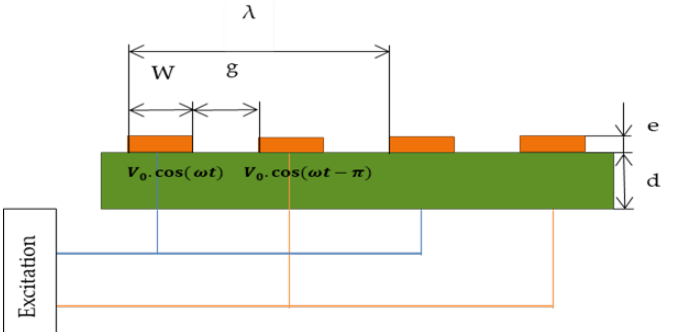
Figure 1. Illustration of the studied 2-phase standing-wave configuration ( w = g = 1 mm, e = 35 µm, d = 1.25 mm, λ = 4 mm).